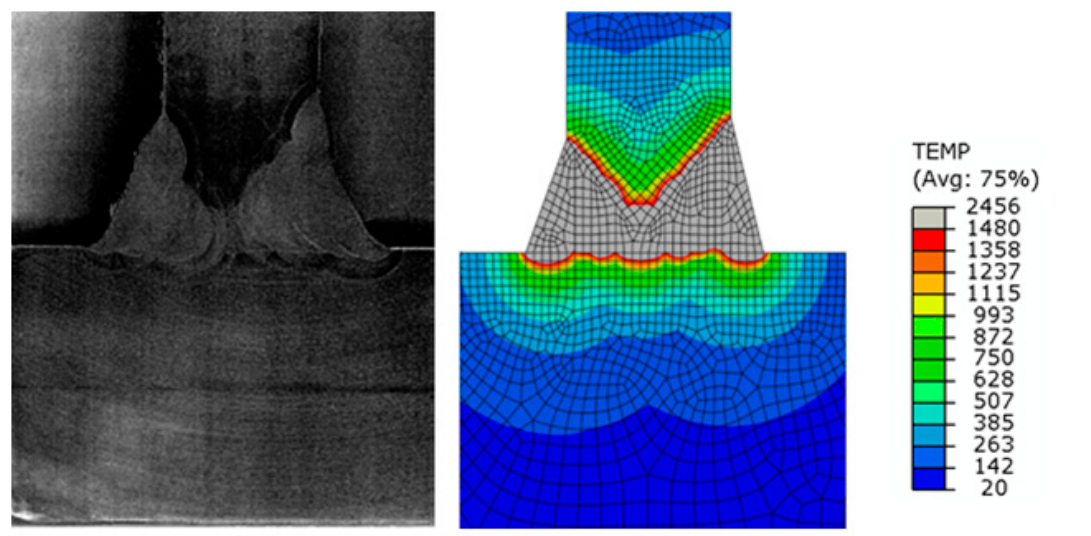
Figure 5 . Fusion boundary in real weld macrograph and FE model. Figure 5. Fusion boundary in real weld macrograph and FE model.